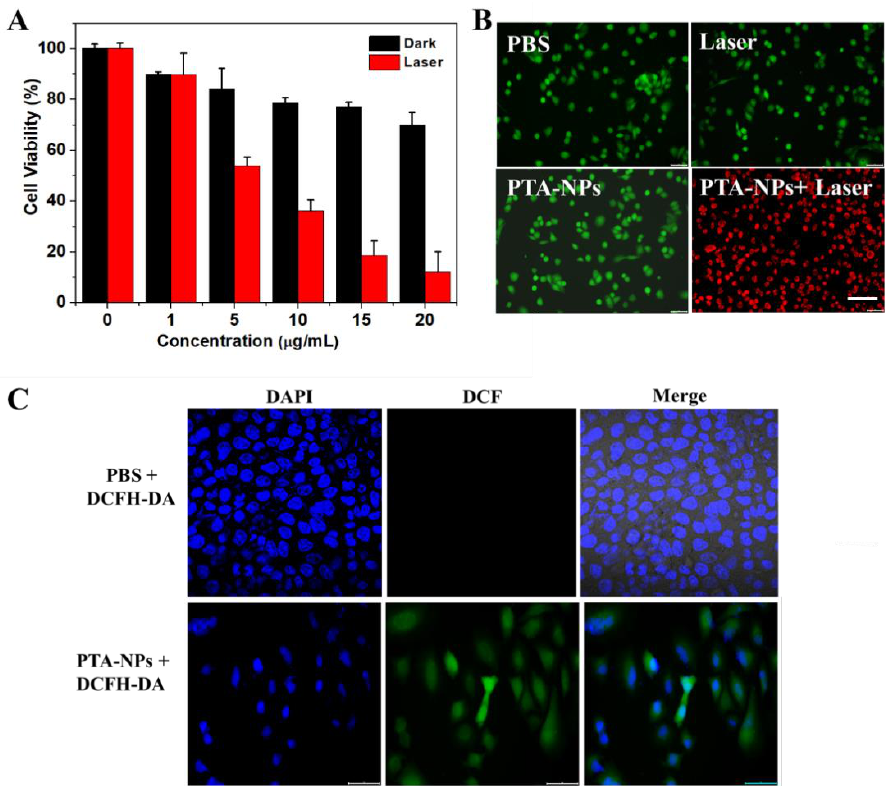
Figure 3. ( A ) Concentration dependence of the cytotoxicity of PTA-NPs against A549 cells; ( B ) fluorescence images of calcein AM (green fluorescence; live cells) and PI (red fluorescence; dead cells) co-stained A549 cells after treated with PBS only, laser irradiation only, PTA-NPs only, or PTA-NPs + laser irradiation (scale bar = 25 μ m); ( C ) the intracellular ROS generation of PTA-NPs using DCFH-DA as a fluorescent probe (scale bar = 25 μ m).